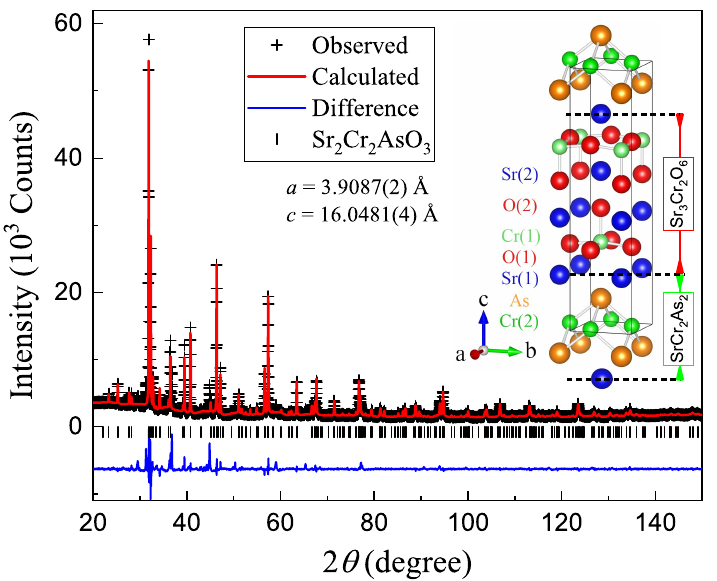
Figure 1. Powder X-ray diffraction at room temperature and its Rietveld refinement profile of Sr 2 Cr 2 AsO 3 . The inset shows the crystal structure consisting of block layers of Sr 3 Cr 2 O 6 and SrCr 2 As 2